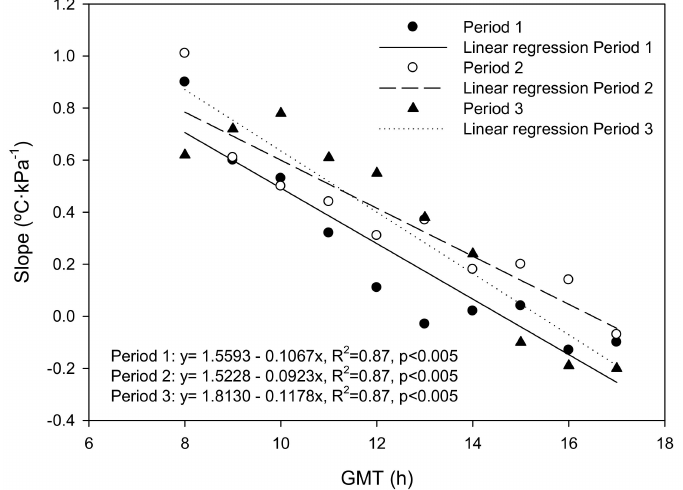
Figure 6. Best-fit to the NWSB-slope for the three periods: 1 (P1, DOY 193-212), 2 (P2, DOY 213-239), and 3 (P3, DOY